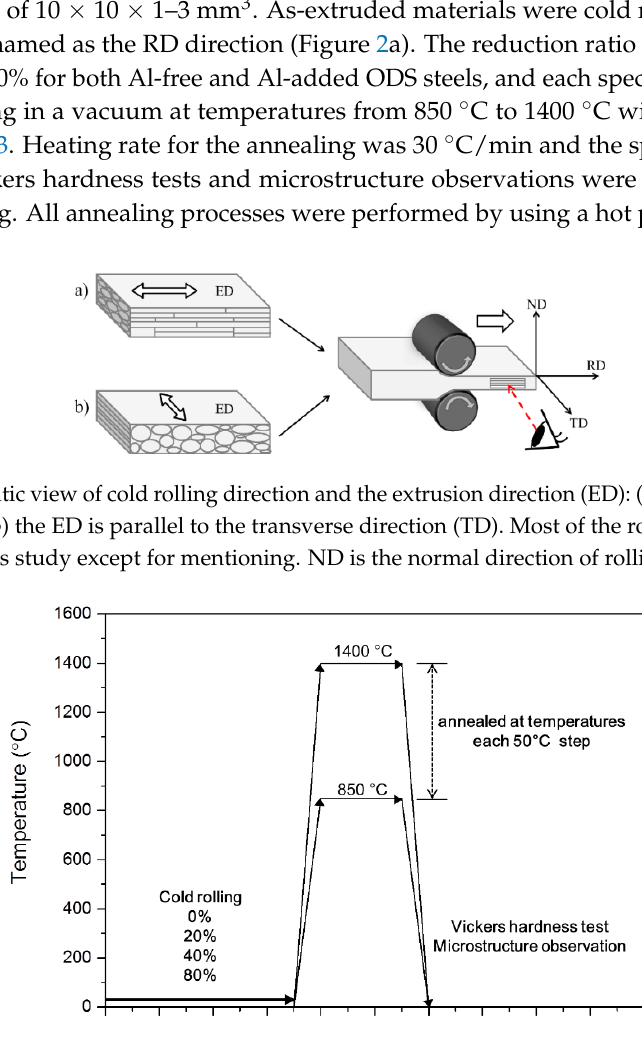
Figure 3. Isothermal annealing to investigate recrystallization behavior of cold rolled 15Cr-ODS ferritic steels with and without Al addition. As-received materials consolidated by hot extrusion processing were cold rolled with 20, 40, 80% reduction of area, and each cold rolled specimen was isothermally annealed for 1 h at each temperature from 850 ◦ C to 1400 ◦ C with 50 ◦ C steps.